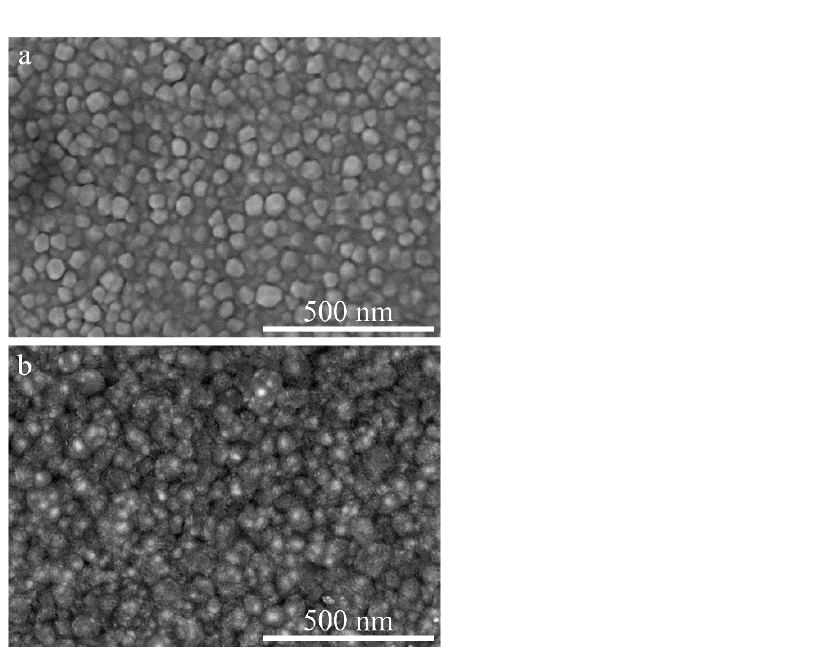
Figure 3. SEM characterization of sputtered Au film on Ti foil ( a ) before and ( b ) after the oxidative etching.